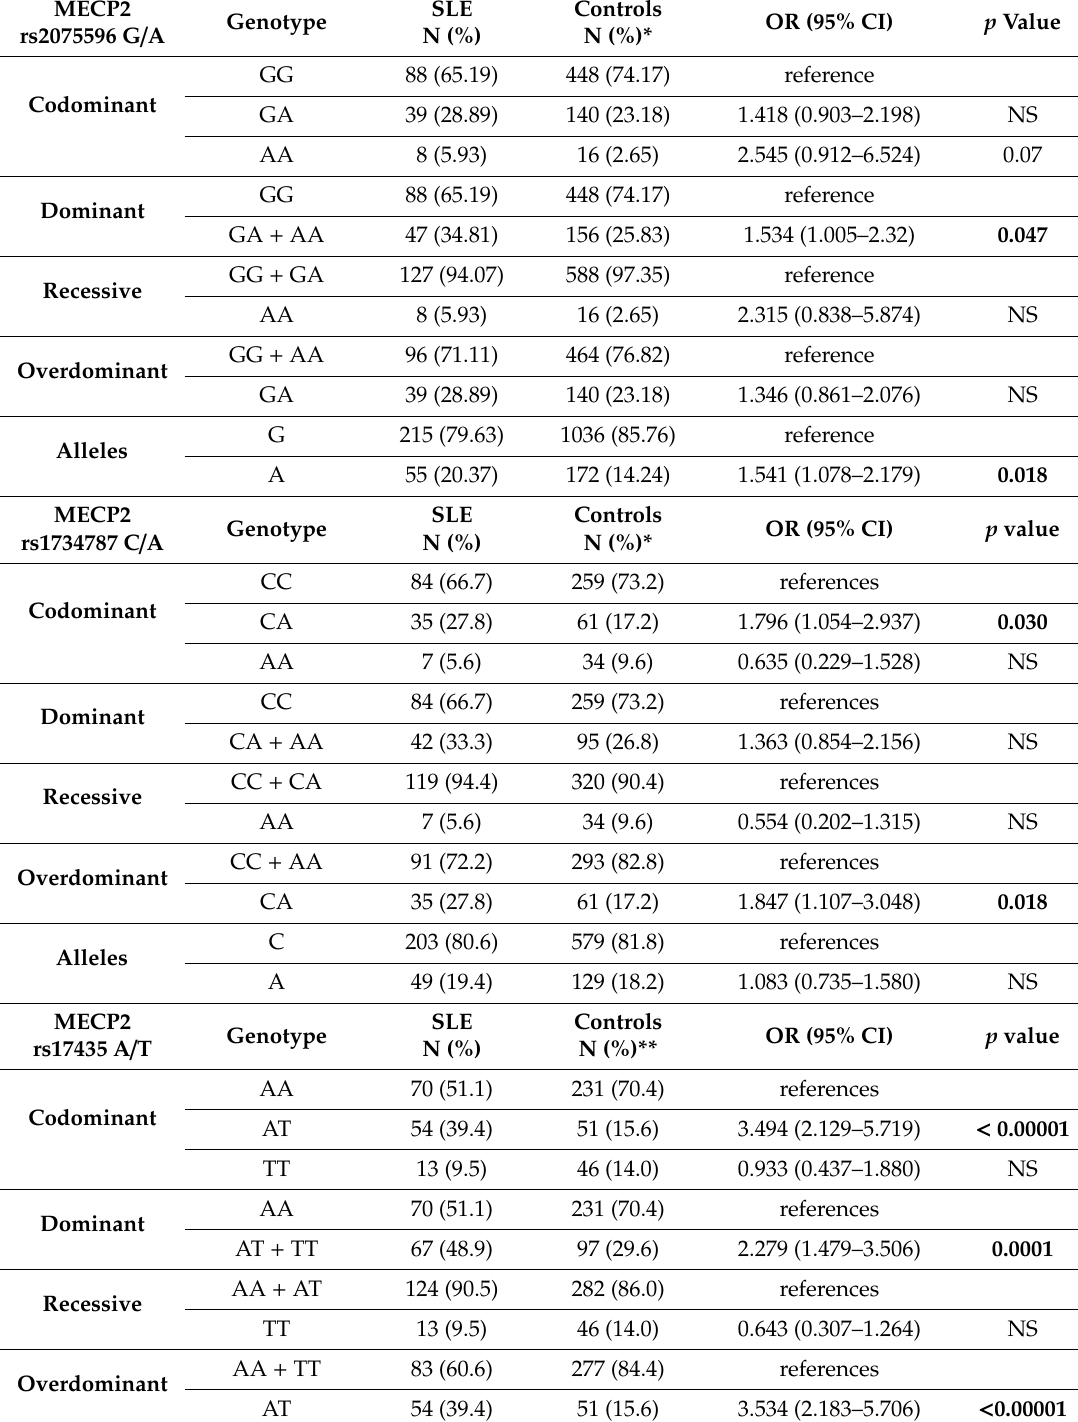
Table 2. Distribution of genotypes and allele frequencies of MECP2 and C-C chemokine receptor type 5 (CCR5) polymorphisms among patients with systemic lupus erythematosus (SLE) and healthy subjects ( p = SLE vs.